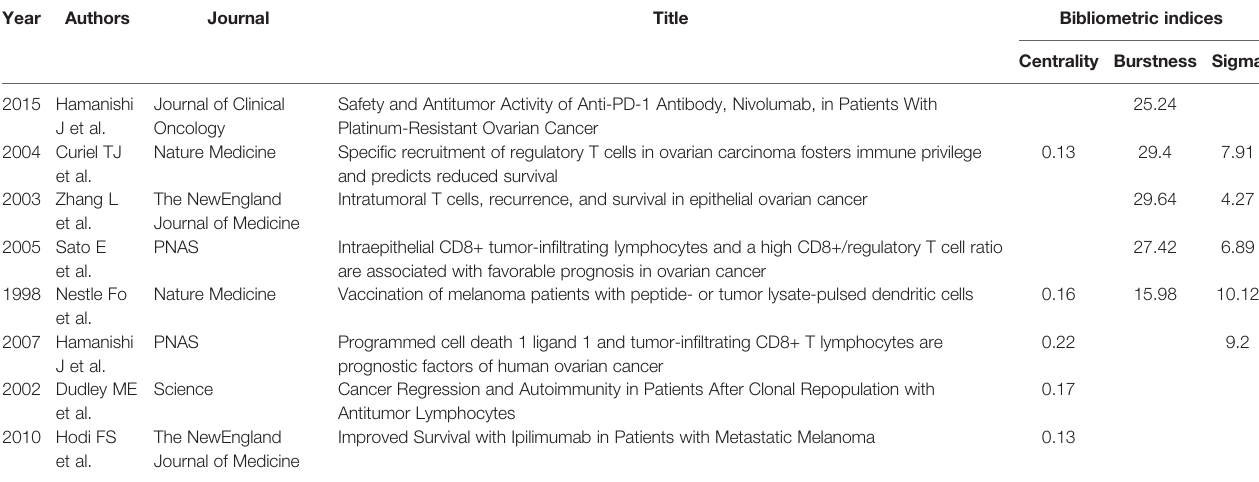
TABLE 1 | Top 5 papers according to three bibliometrical indices in the fi eld of immunotherapy of ovarian